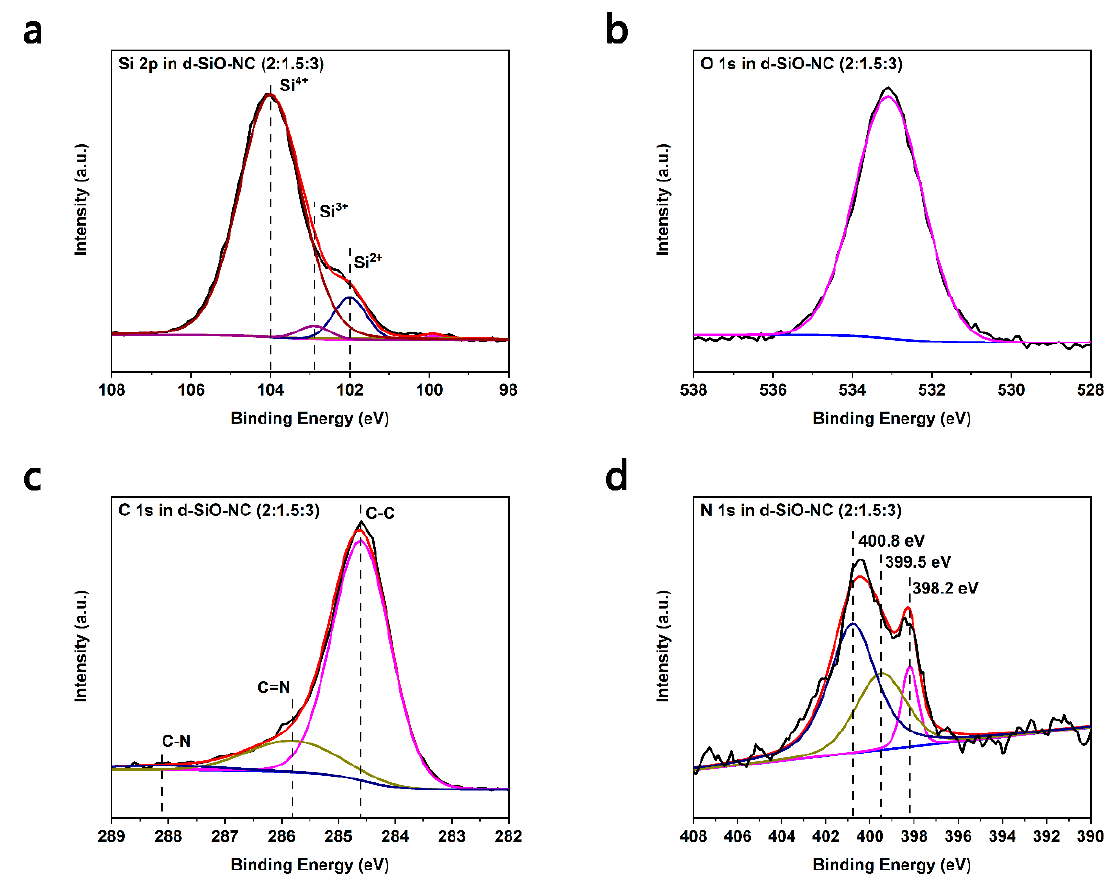
Figure 4. XPS spectra of d-SiO-NC (2:1.5:3). ( a ) Si 2p, ( b ) C 1s, ( c ) O 1s, ( d ) N 1s.